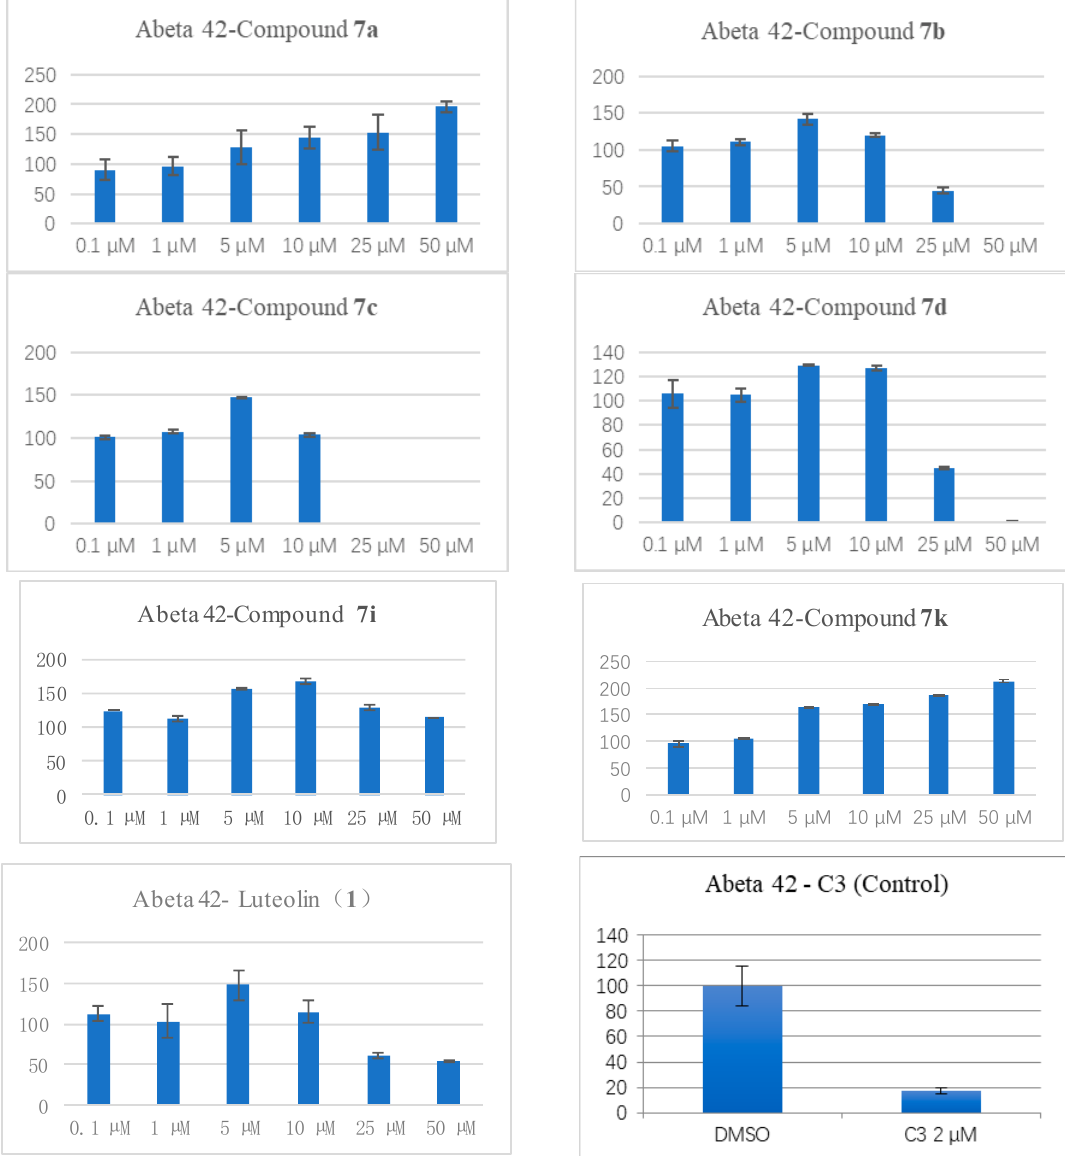
Figure 6. The normalized A β -42 level in amyloid precursor protein (APP) overexpressing HEK293 cells after the treatment of 7a–d , 7i , 7k , and luteolin compared with DMSO (100%), the known inhibitor C3 [15].